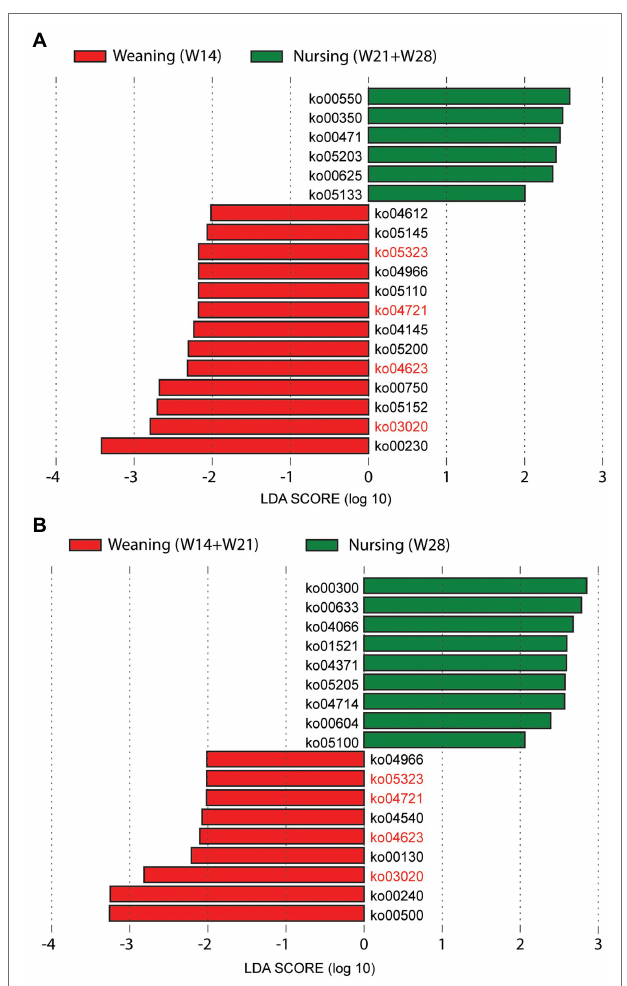
FIGURE 4 | Comparison of archaeal KEGG KOs difference between weaning and nursing group on day 21 (A) and 28 (B) using LEfSe